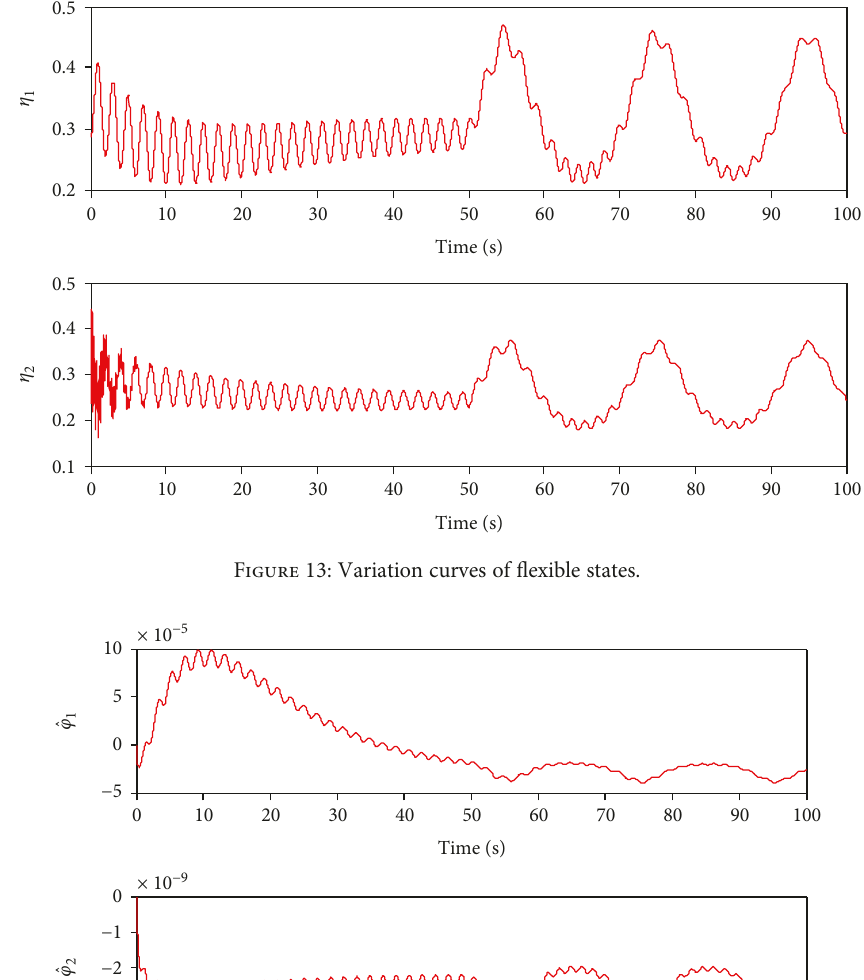
Figure 14: Estimations of φ